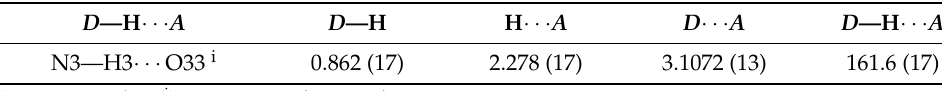
Table 6. Hydrogen bond geometry (Å, ◦ ) in 4a .